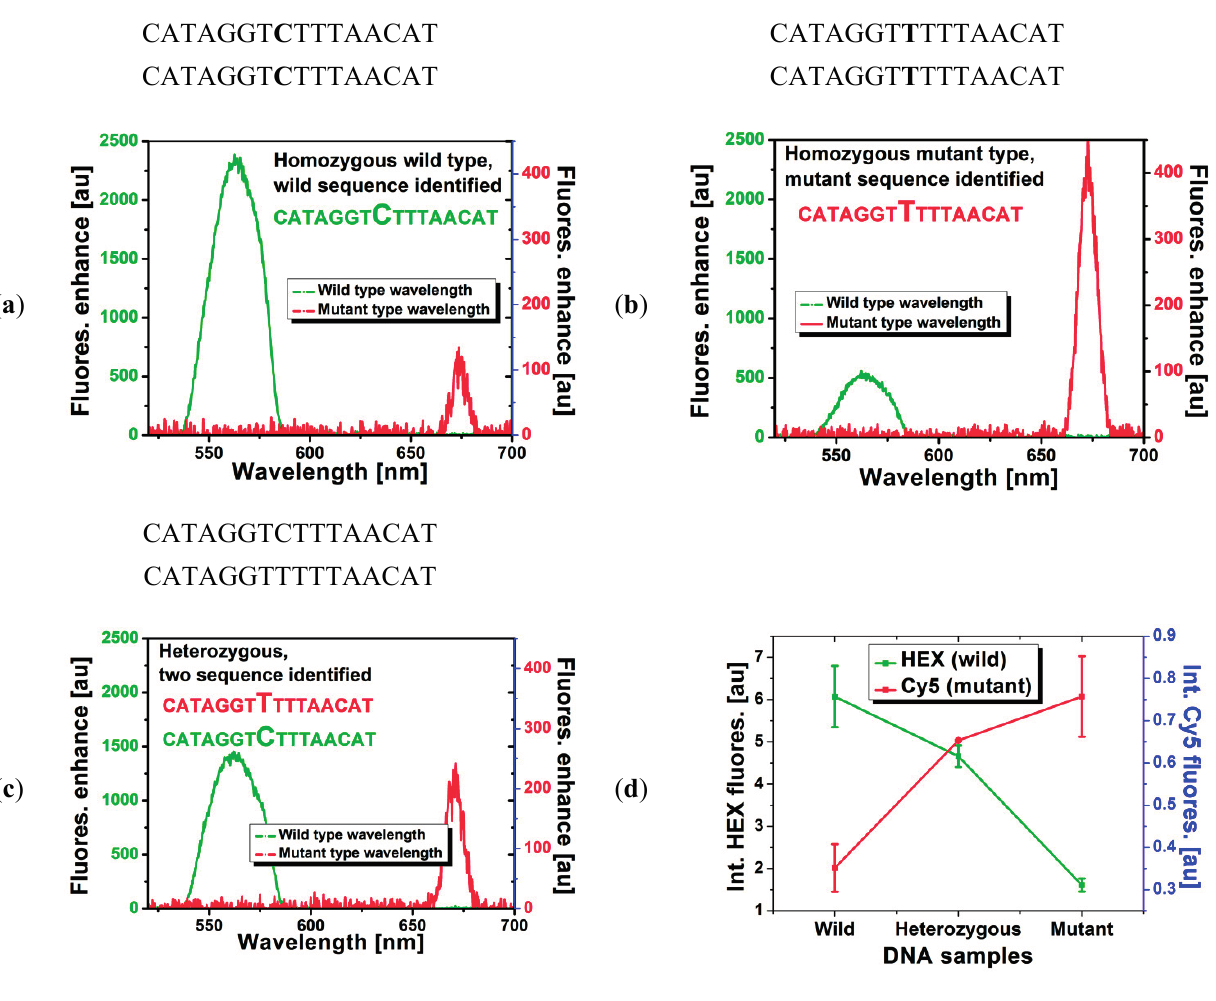
Figure 4. Hybridization test of the dual-type MB immobilized SCF filled with solution containing either one type of DNA sequence, e.g., wild or mutant sequence (homozygous) or both type (heterozygous). Fluorescence enhancement clearly indicates ( a , b ) the homozygous type or ( c ) heterozygous type; ( d ) The averaged value over four measurements of spectra as shown in (a–c), crossing point of HEX and Cy5 fluorescence indicate heterozygousity and well separated values of HEX and Cy5 fluorescence represent